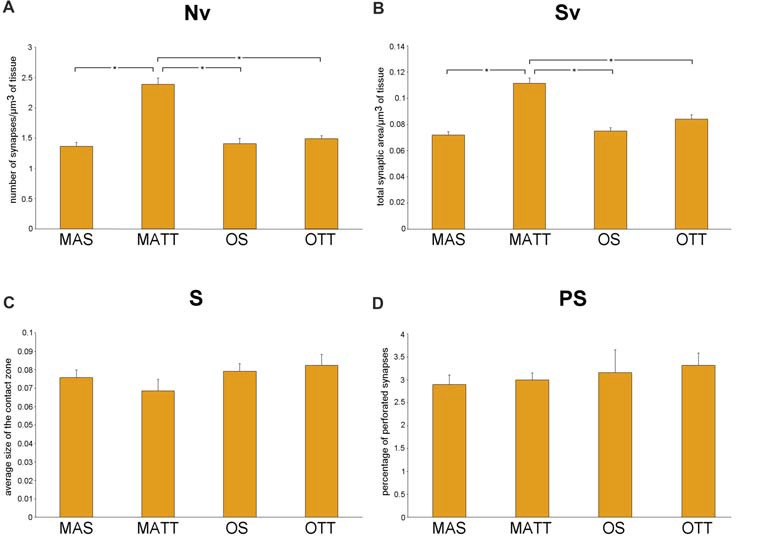
(A–D) Mean value ± standard error of the mean (SEM) of synaptic ultrastructural variables measured in the inner molecular layer of dentate gyrus (IMLDG) in middle-aged sedentary (MAS), middle-aged running (MATT), old sedentary (OS) and old treadmill-exposed (OTT) mice. Nv, numeric density of synapses; Sv, surface density of synapses; S, average size of synaptic contacts; PS, percent of perforated synapses. Asterisk indicates between-group statistically significant differences (p ≤ 0.05; Bonferroni’s post hoc test).